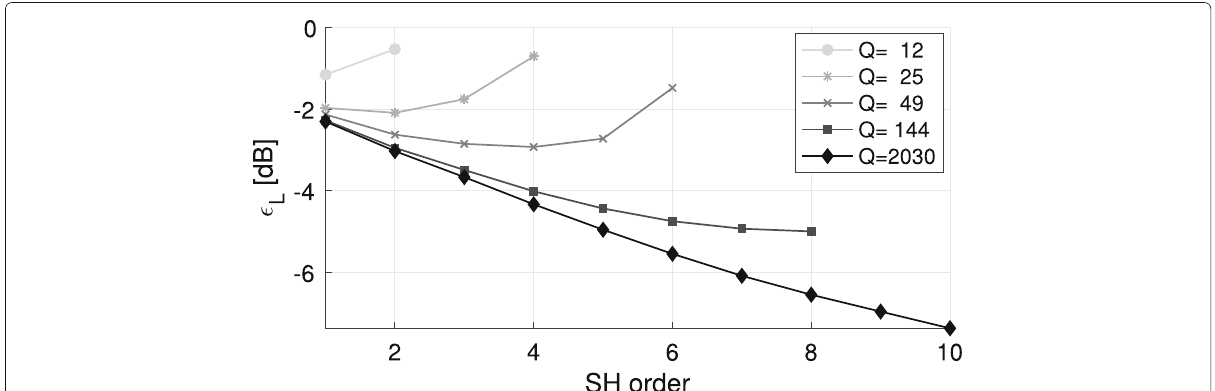
Fig. 1 Reconstruction error, (cid:8) L , for left ear HRTF, computed using Eq. (12), with different numbers of measurement points and different SH orders